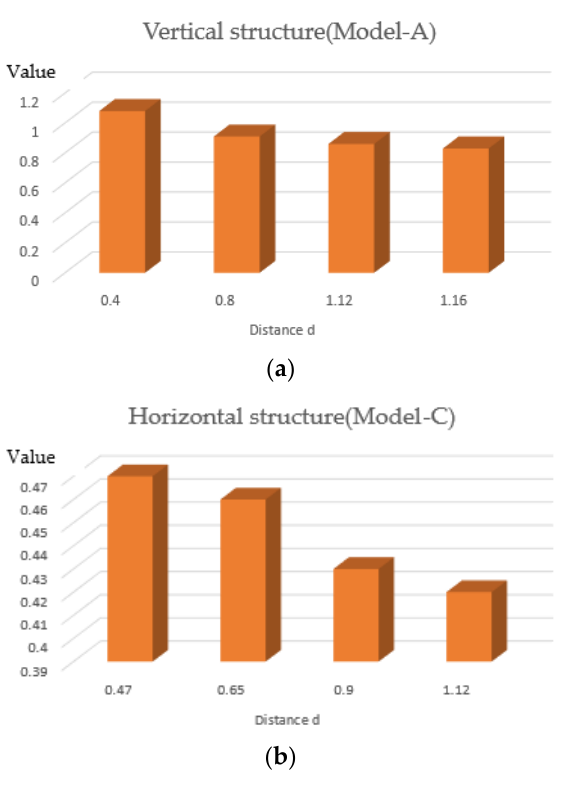
Figure 9. FEM results of coupling capacitance under different distances: ( a ) vertical structure coil model and ( b ) horizontal structure coil model. Table 4. Influence of the coupling capacitance under different distances d with the FEA method.